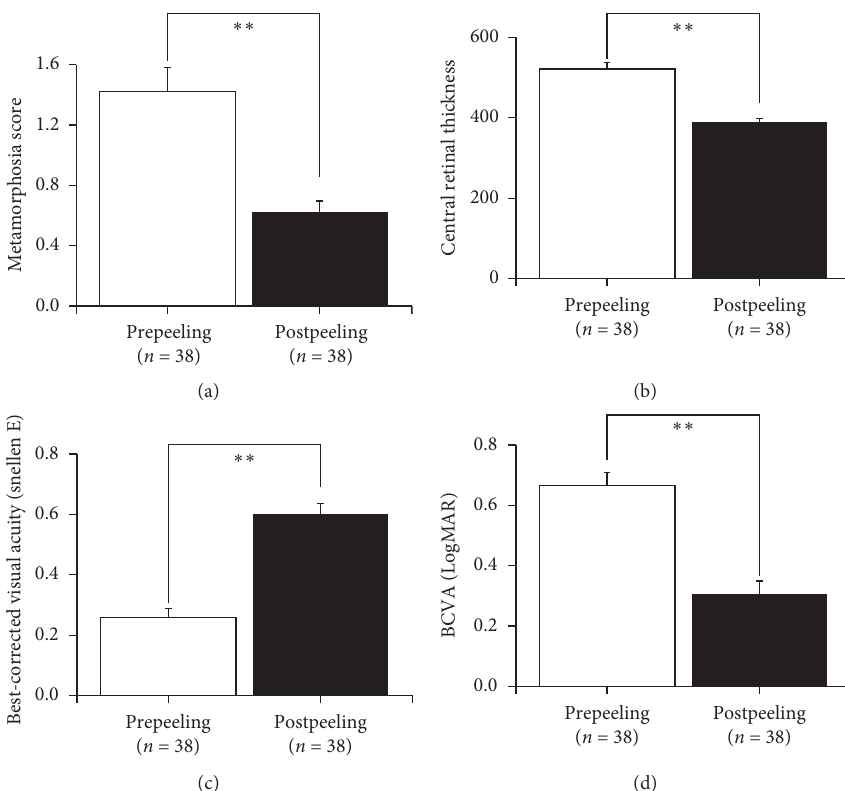
Figure 1: (a) As compared to the baseline (prepeeling), postpeeling metamorphopsia score was significantly improved (reduced score). (b) As compared to the baseline (prepeeling), postpeeling CRT was significantly decreased. (c) and (d) As compared to the baseline (prepeeling), postpeeling BCVA was significantly improved (increased Snellen E and decreased LogMAR), respectively. Abbreviations: CRT, central retinal thickness; BCVA, best-corrected visual acuity; LogMAR: Logarithm of the minimum angle of